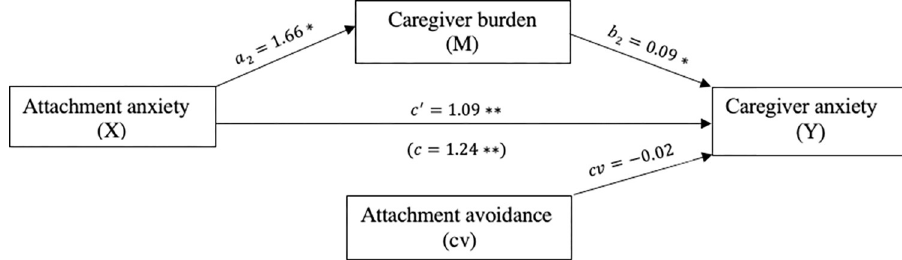
Fig 2. The mediating effect of caregiver burden in the relationship between attachment anxiety and caregiver anxiety. � p < 0.05, �� p < 0.001, cv = covariate.